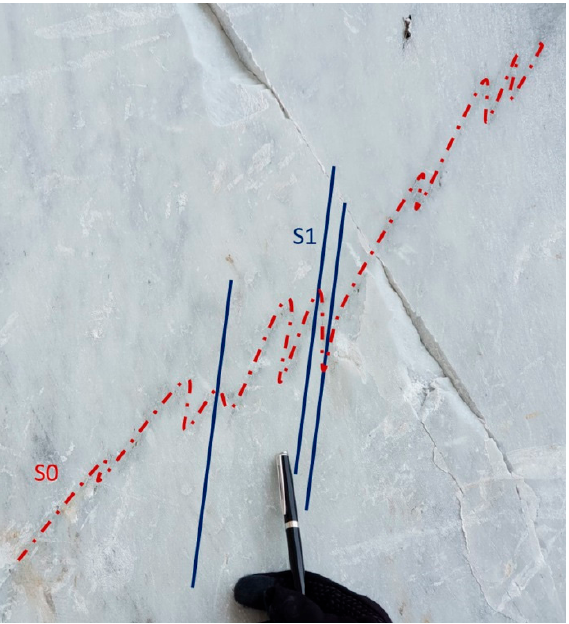
Figure 4. Outcrop-scale evidence of deformed of bedding (S0) and foliation (S1) in the “marmi s.s.” (marble).